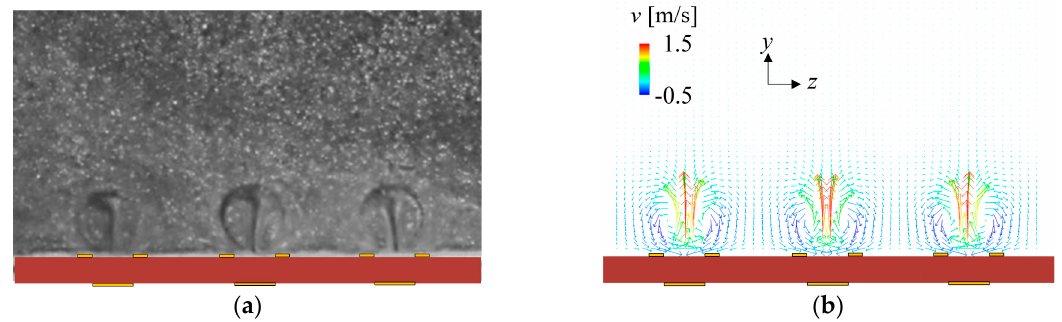
Figure 11. Vortices induced by actuators in the absence of a freestream flow: ( a ) visualized flow in the experiment; and ( b ) the predicted velocity vectors color-coded by values of the vertical velocity.